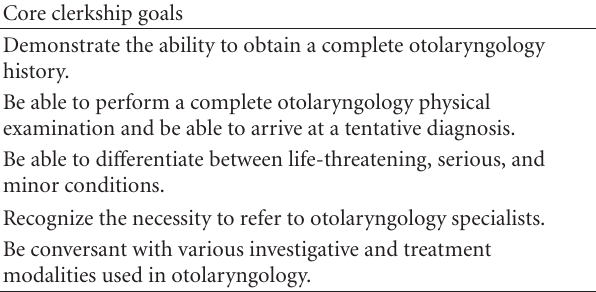
Table 1: Core clerkship objectives (from Campisi et al.). Core clerkship